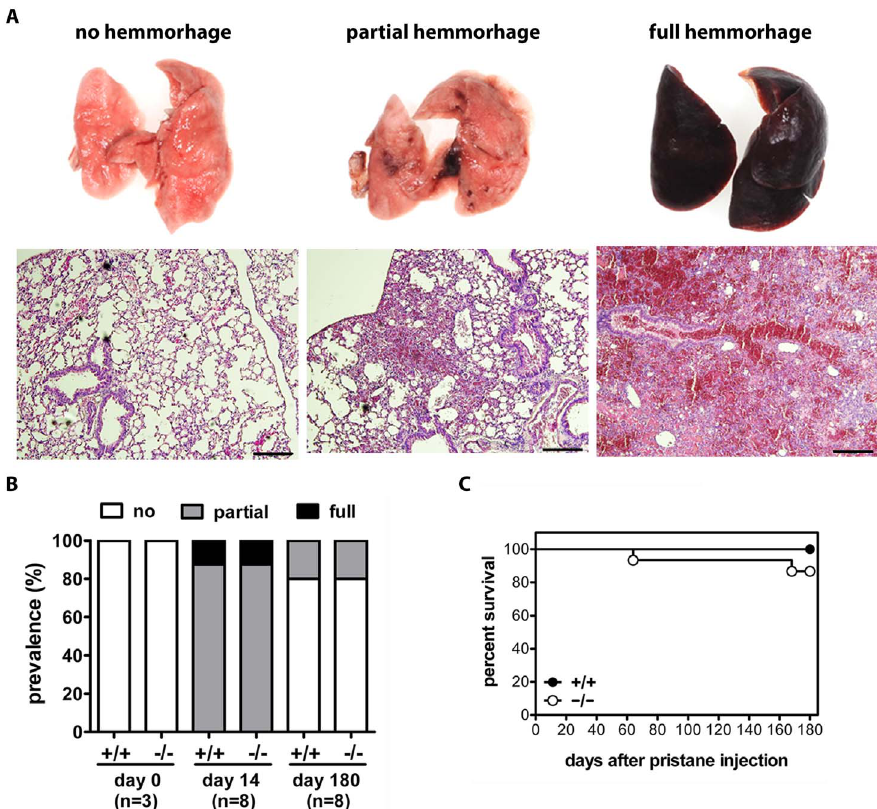
Fig. 7. Transient alveolar haemorrhage develops after pristane-injection in both WT and CRAMP 2 / 2 mice. (A) Classification of lung pathology in pristane-injected mice. Representative images and H&E- stainings of C57BL/6 mice two weeks after pristane-injection, with lungs showing no hemorrhage, partial, or full hemorrhage. Scale bars, 200 m m. (B) Time course of pristane-induced alveolar hemorrhage in WT and CRAMP 2 / 2 mice. Incidence and types of gross pathology at day 0, day 14, and day 180 after pristane- injection. (C) Low mortality after pristane-injection in both CRAMP + / + (n 5 14) and CRAMP 2 / 2 (n 5 15) mice. No significant differences could be found by Logrank